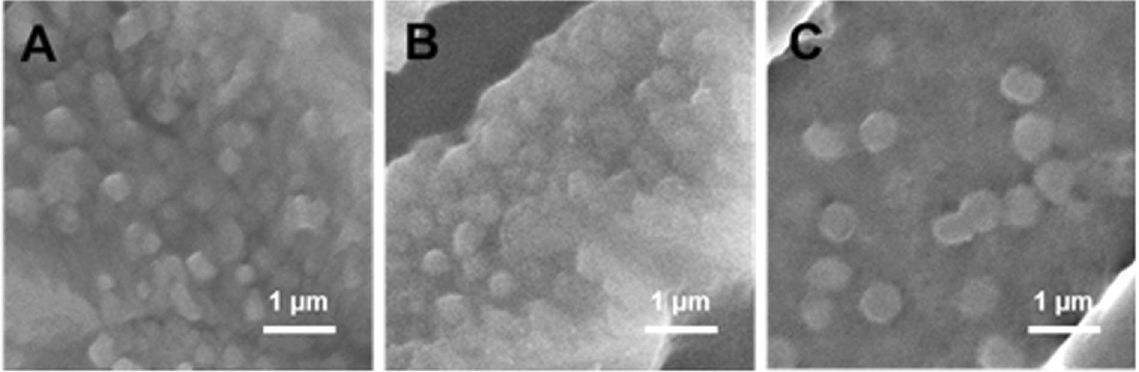
Figure 10. SEM images of liquid samples under pH 2 ( A ), 4 ( B ) and 7 ( C ) of pectin-coated LPN (prepared with conjugate Dex75-3).